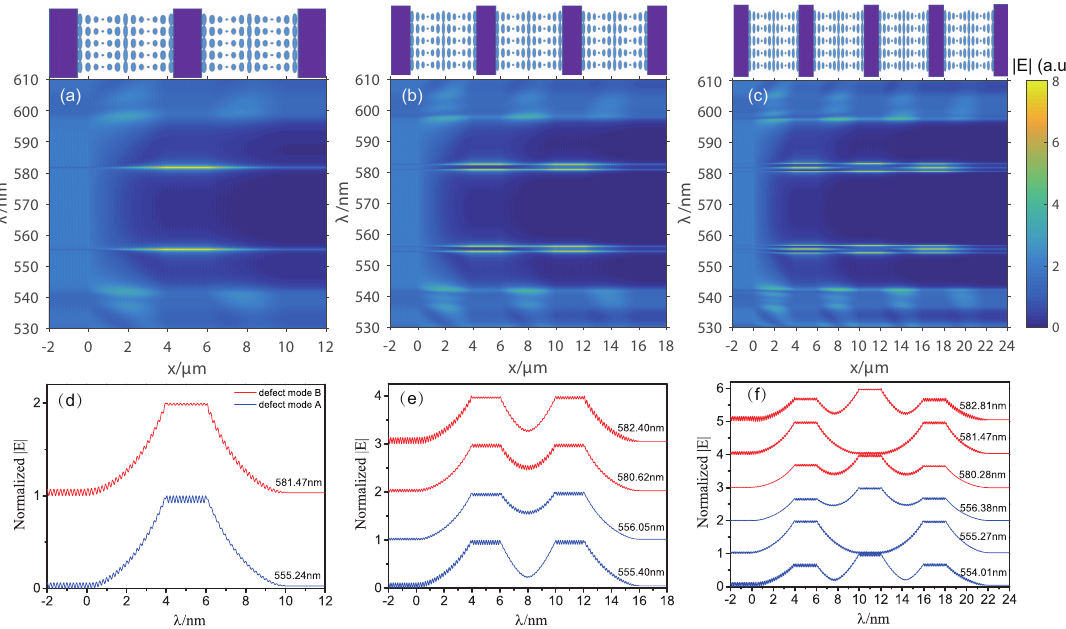
Figure 4. Electric field distributions for RCP light in composite structures with ( a ) one, ( b ) two, and ( c ) three isotropic layers; ( d – f ) electric field profiles of the defect modes at their resonant wavelengths, corresponding to ( a – c ),